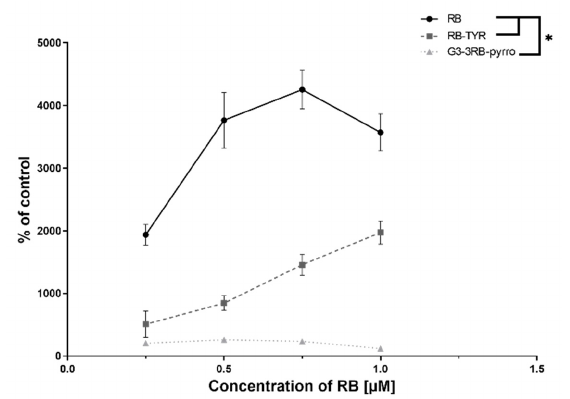
Figure 9. Comparison of singlet oxygen generation by free rose bengal (RB), rose bengal modified with tyramine (RB–TYR) and conjugate of phosphorus dendrimer of the third generation with rose bengal (G3–3RB–pyrro). Data presented as mean ± SD. * p < 0.05.